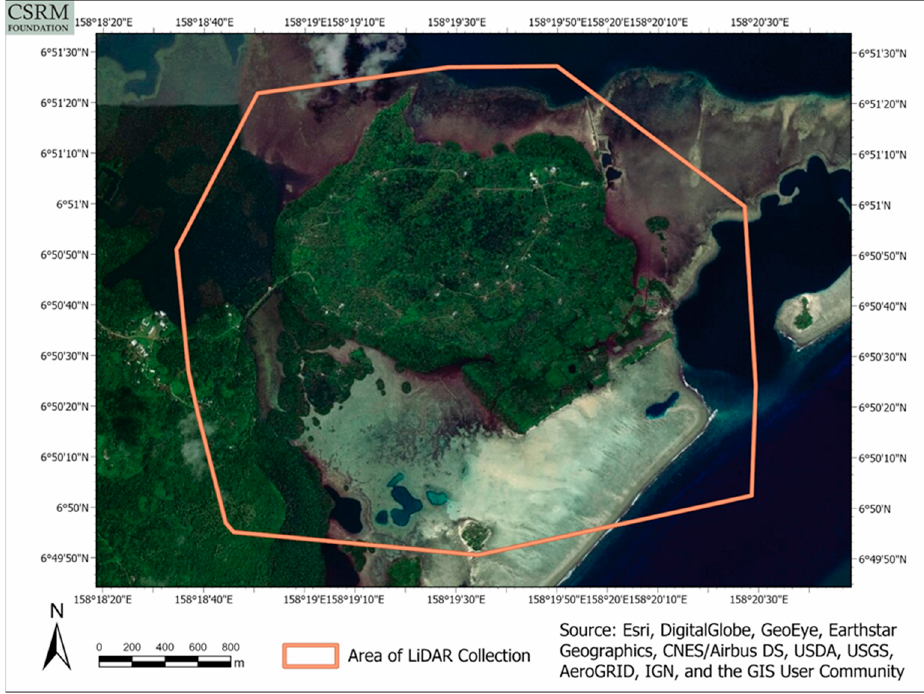
Figure 2. The area surveyed with LiDAR.